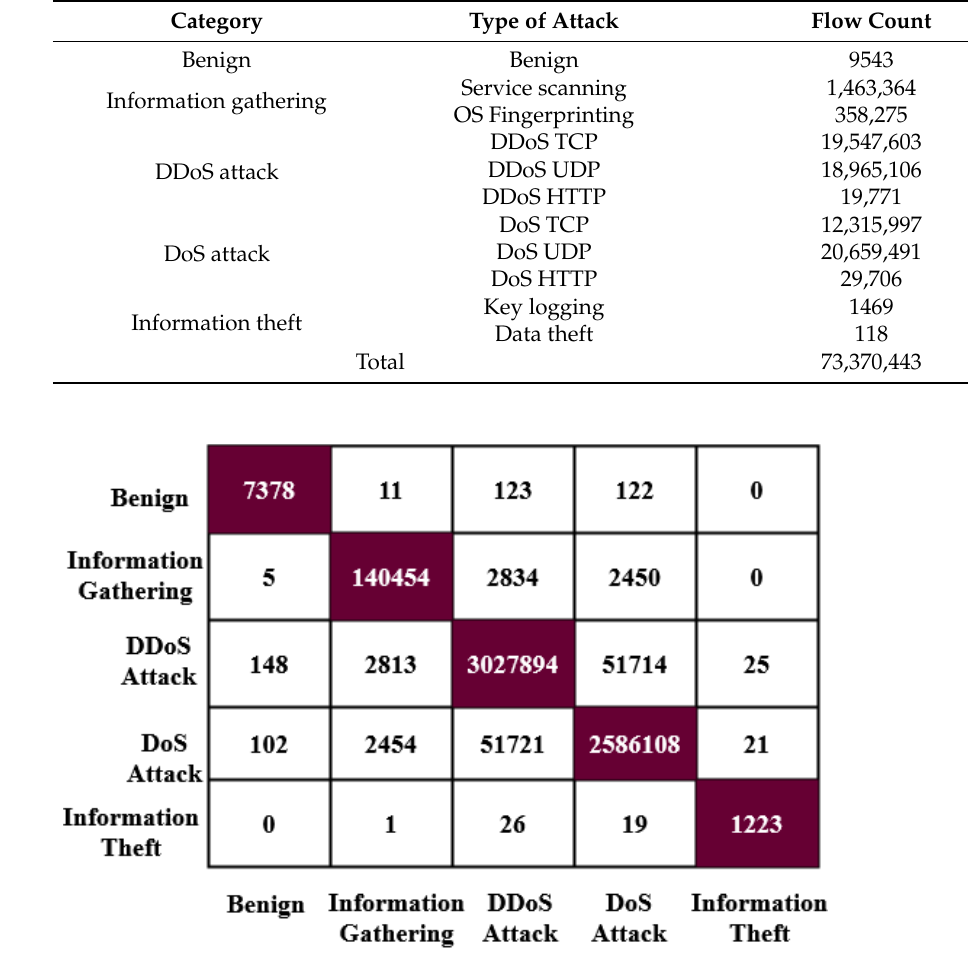
Figure 4. Confusion matrix for the BoT-IoT dataset.